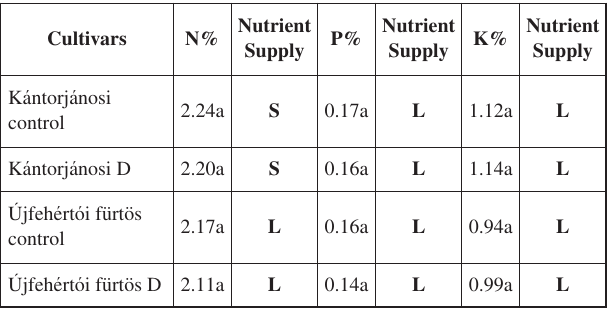
Legend: L-low, S-sufficient In each c Column, means followed by the same letter are not significantly different (P<0.05). Nutrient contents were expressed in percentage of dry matter